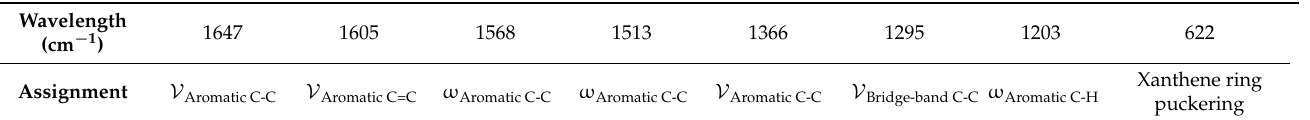
Figure 7. ( a ) The SERS spectra of RhB at various concentrations. ( b ) The standard curve between the SERS intensity of the 1647 cm − 1 peak and the various concentrations of RhB. ( c ) The SERS spectra of the 10 − 7 M and 10 − 10 M RhB at different positions on the GMP-coated substrates. ( d ) The intensities at the 1647 cm − 1 peak of different spectrums, with their AVG and RSD values. Table 1. The SERS assignment of rhodamine B. (Adapted with permission from Ref. [60]. Copyright 2014, nature publishing